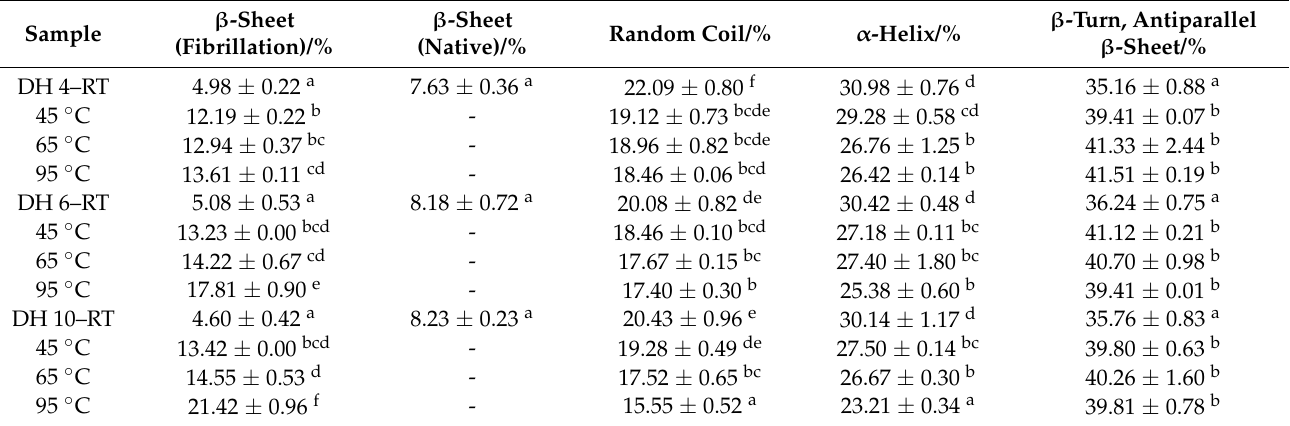
Table 1. Effect of the DH and thermal treatment on the secondary structure of GPs heated for 120